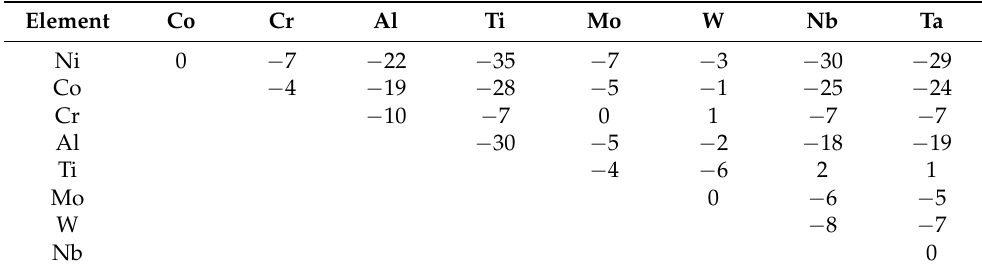
Table 3. Mixing enthalpy of binary atomic pairs in various alloy systems (kJ mol − 1 ) [21].